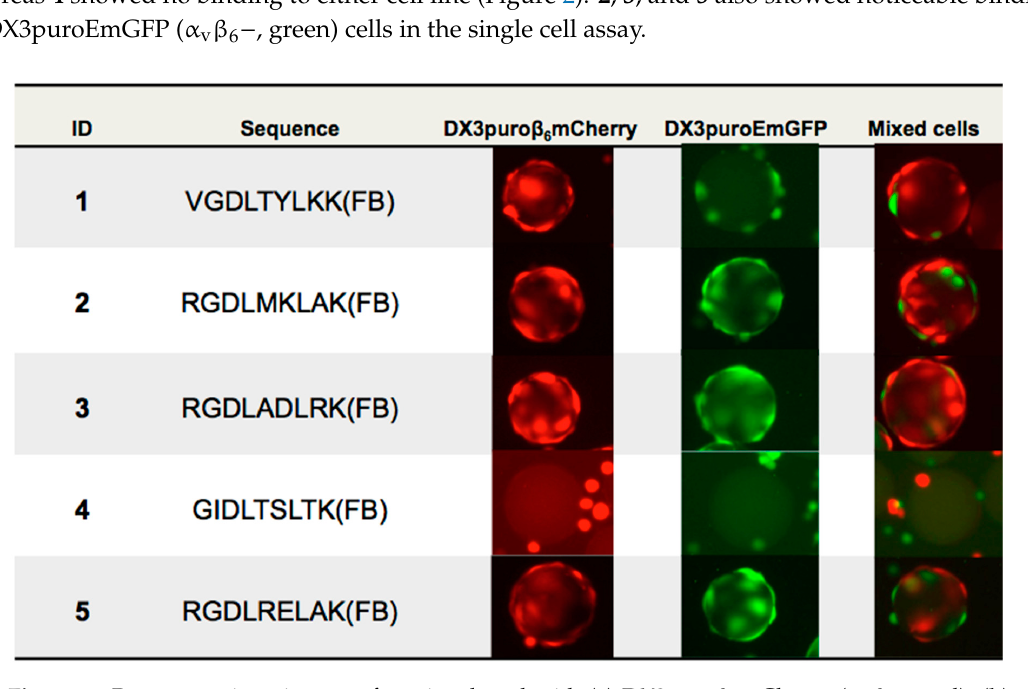
Figure 1. Schematic representation of the On ‐ Bead Two ‐ Color (OBTC) cell screening utilizing fluorescent DX3puro β 6 mCherry ( α v β 6 +, red) and DX3puroEmGFP ( α v β 6 − , green) cells.